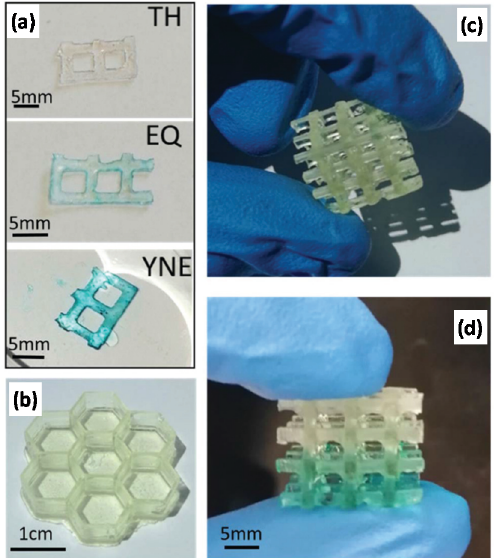
Figure 17. Illustrations of the 3D printed objects produced in [78]. ( a ) Result of the post functional- ization step with the squaraine dye for the three thiol-yne formulations. ( b ) Structure built with the stoichiometric formulation (EQ), ( c ) hybrid structure with the two off stoichiometric formula- tions (YNE at the bottom and TH at the top), and ( d ) result of the post functionalization process on the same structure. Reproduced from [78] with the permission from The Royal Society of Chemis- try.